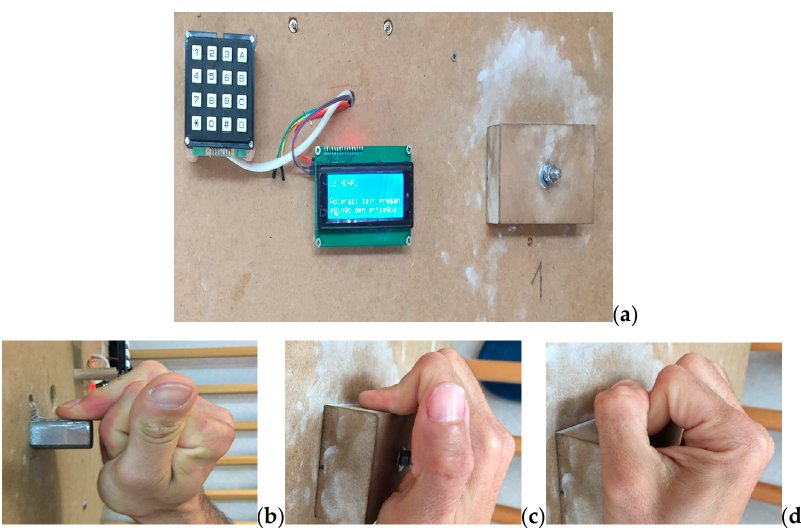
Figure2. Bindarandgriptypes. ( a )Bindardevice. ( b )Onefingercrimp. ( c )Opencrimp. ( d Figure 2. Bindar and grip types. ( a ) Bindar device. ( b ) One finger crimp. ( c ) Open crimp. ( d ) Close crimp.